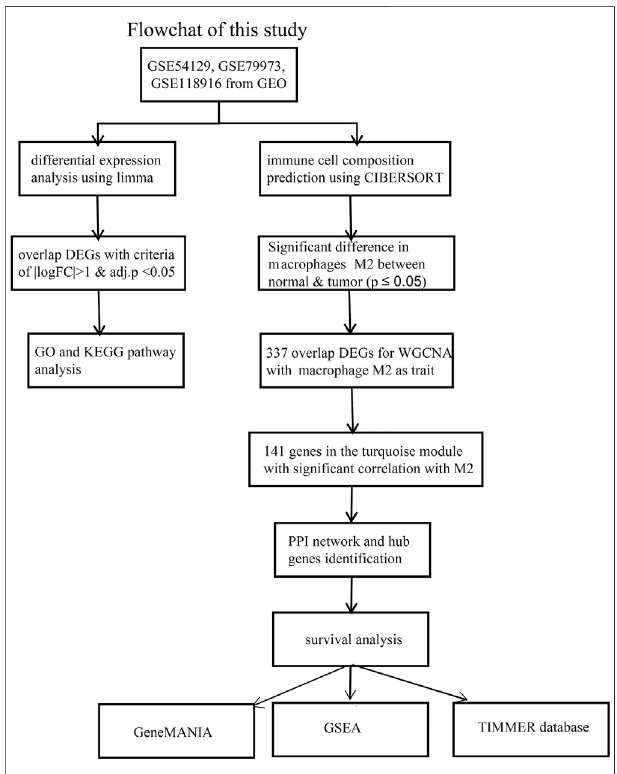
FIGURE 1 | The work fl ow of the identi fi cation of hub genes related to Macrophage immune in fi ltration in